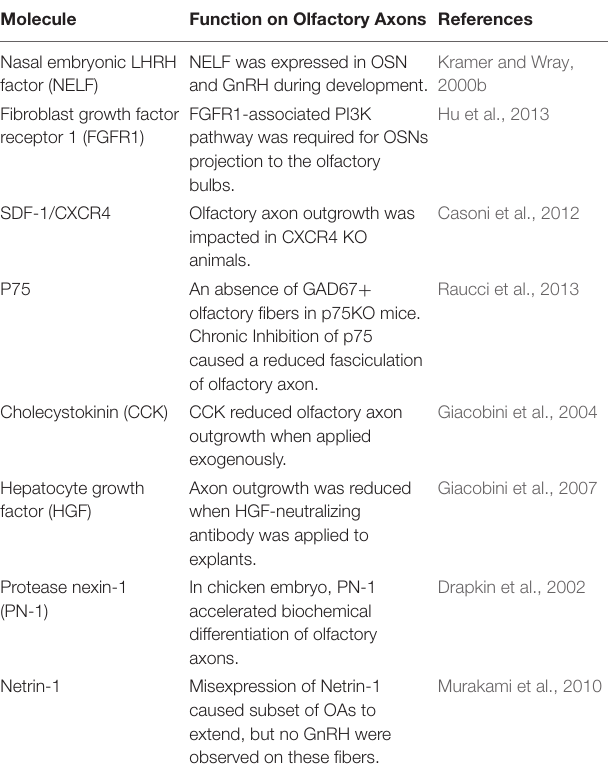
TABLE 1 | Guidance molecules involved in embryonic olfactory axon outgrowth.